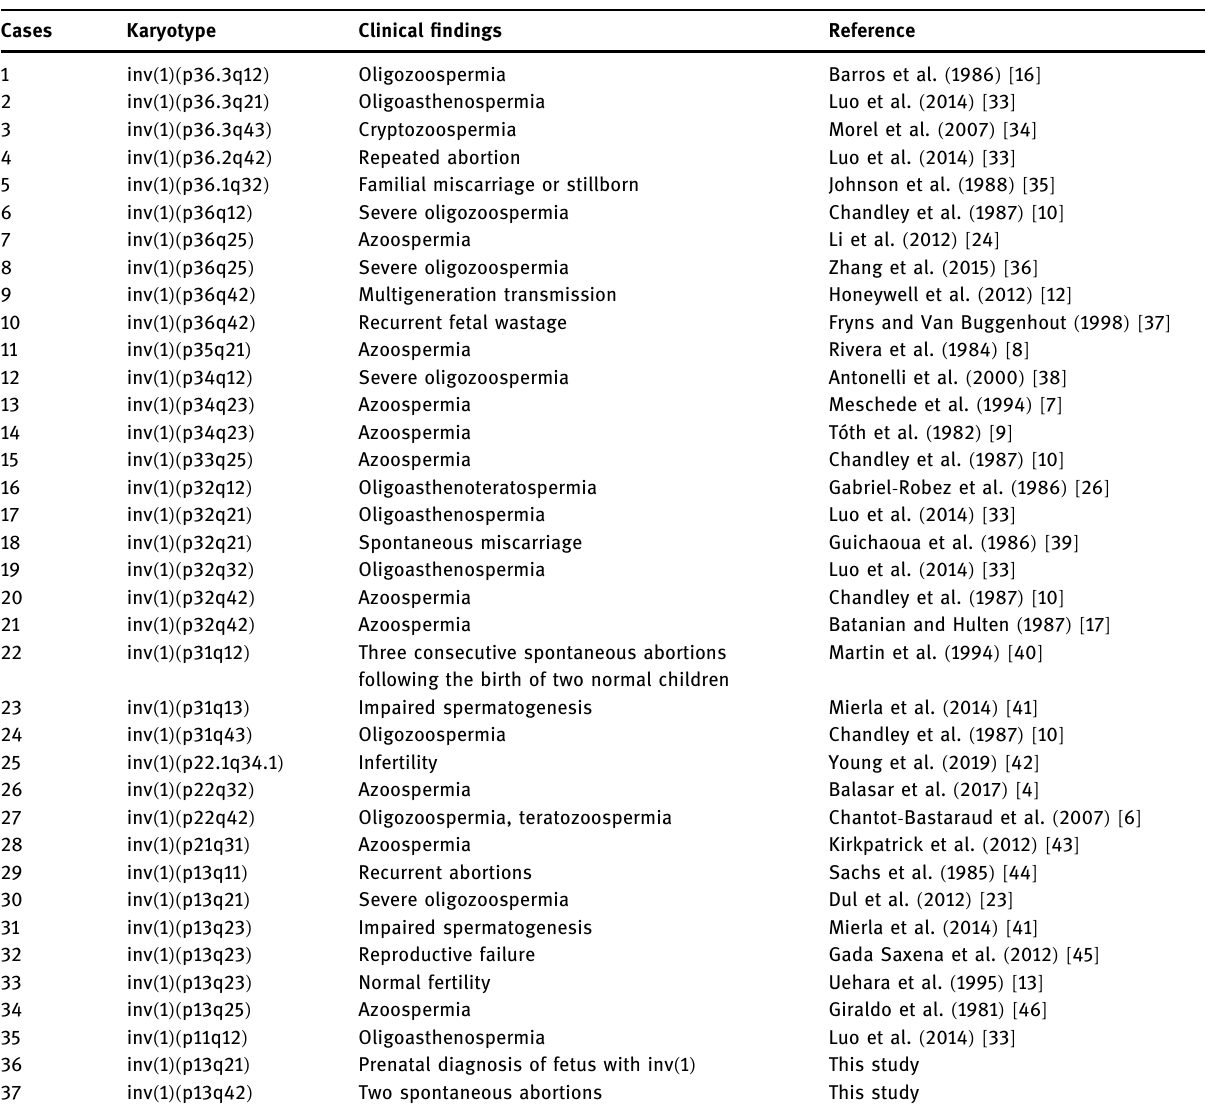
Table 1: Clinical features and karyotype of carriers with pericentric inversion in chromosome 1 reported in the previous literature